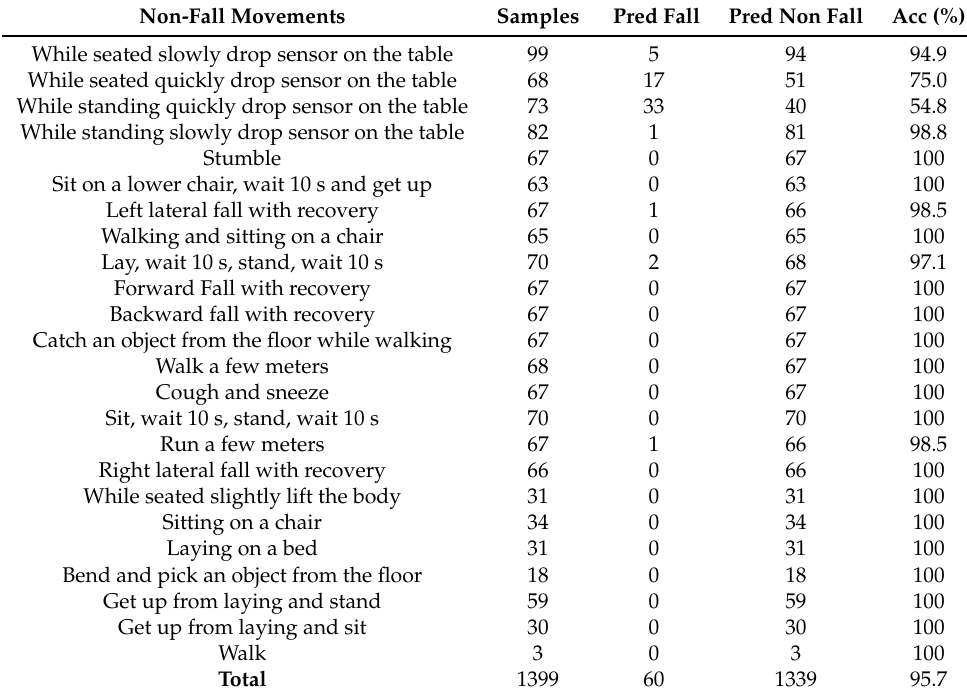
Table 3. Results of the medium sensitivity level of thresholds trained with data at 50 Hz with whole dataset DS-1 . The results are divided by type of movement in order to analyze the movements that are more often